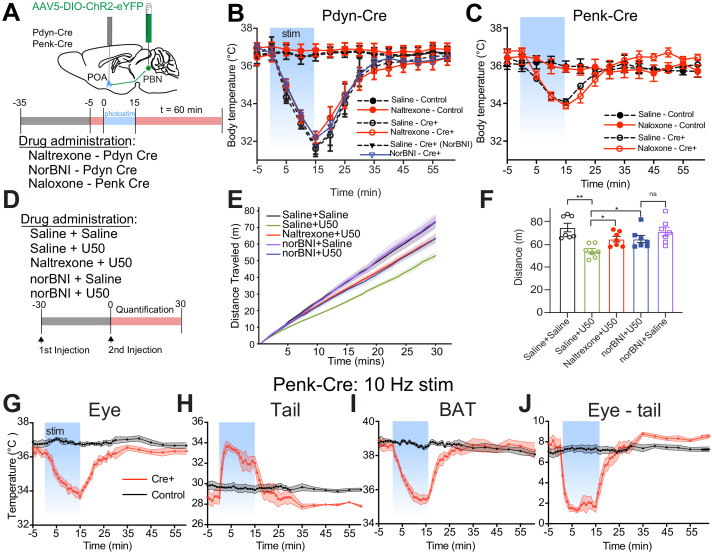
PdynPBN→POA or PenkPBN→POA photostimulation-induced hypothermia is independent of opioid system.(A) Illustrations of viral injections and fiber optic implantation in Pdyn-Cre and Penk-Cre mice and timeline of drug administration/photostimulation/temperature recording trials. (B) Body temperature vs. time graphs for 10 Hz photostimulation of PdynPBN→POA and control with IP saline, naltrexone (red), or norBN (blue) administration. Photostimulation was delivered from t = 0 to t = 15 min and led to equivalent levels of hypothermia in Cre+ mice regardless of pharmacologic pretreatment. Body temperature of controls was consistent throughout the trial. Data are presented as mean ± SEM. n = 6–7 animals/group. (C) Body temperature vs. time graphs for 10 Hz photostimulation of PenkPBN→POA in Penk-Cre and control mice with prior IP naloxone or saline administration. Pretreatment did not alter the responses to photostimulation in Penk-Cre mice. Data are presented as mean ± SEM. n = 5 animals in each group. (D–F) To examine effectiveness of antagonist pretreatment we examined the impact of administration naltrexone and norBNI on U50 (5 mg/kg) mediated suppression of locomotor activity. (D) Saline or antagonists were administered 30 min prior to U50 (or saline) in the combinations listed and locomotor activity tracked for 30 min after U50 injection. (E) The cumulative distance traveled and total distanced traveled show marked suppression of movement by U50 which was ameliorated by pretreatment with naltrexone or norBNI (24 hr plus 30 min prior). (F) Total distance traveled at 30 min after U50 administration significantly (p=0.002) reduced compared to saline. This decrease in locomotion was reduced significantly by pretreatment naltrexone (p=0.014) or norBNI (p=0.025). norBNI followed by U50 was not significantly different from norBNI followed by saline. n = 5 mice. (G–H) Results obtained using quantitative thermal imaging to measure tail, eye, and BAT temperatures in Penk-Cre mice during 10 Hz photostimulation as done for Pdyn-Cre mice in Figure 4. (G) Eye, (H) tail, (I) BAT, and (J) eye minus tail temperature vs. time graphs for 10 Hz photostimulation of PenkPBN→POA. Photostimulation was delivered from t = 0 to t = 15 min and led to drops in eye and BAT temperatures. Tail temperature rose and the gradient between eye and tail temperatures declined in Cre+ animals but not control mice. Data are presented as mean ± SEM. n = 5 in each group.